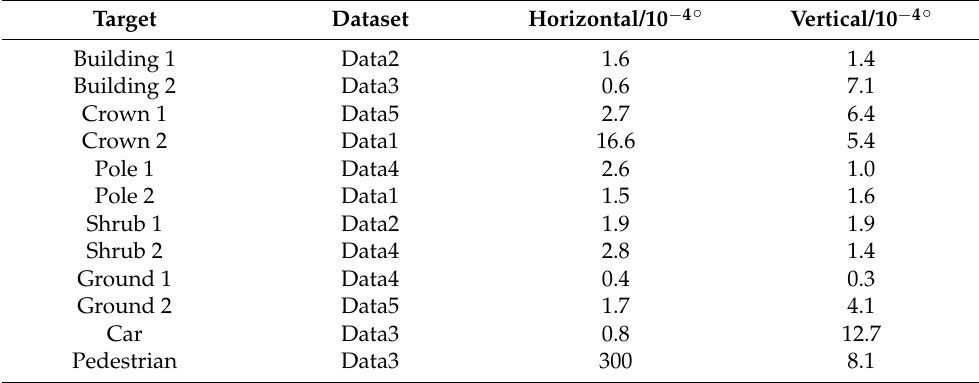
Table 5. Estimation error of different types of objects.